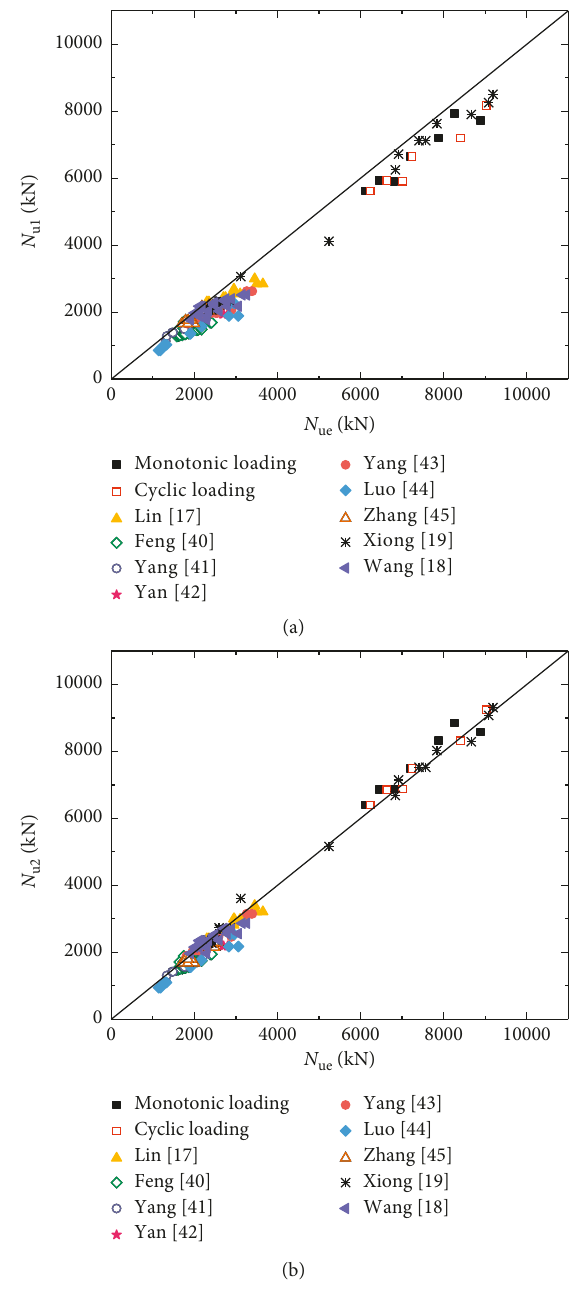
Figure 11: Comparison of test results with design strength based on Eurocode 4. (a) Comparison of test results with prediction from equation (7). (b) Comparison of test results with prediction from equation